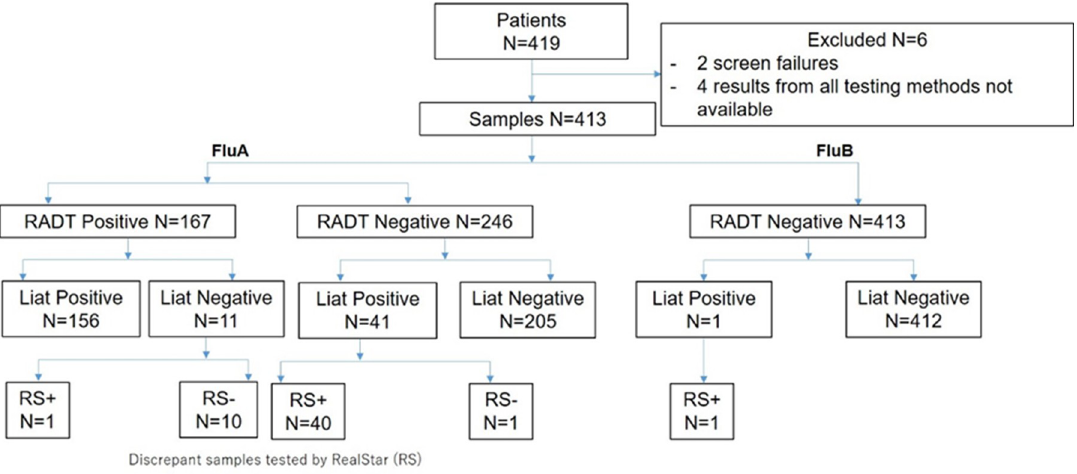
Fig 1. Patient flow. Discrepant samples were tested by RealStar; invalid RS samples (N = 4) were excluded from further analysis. RADT, rapid antigen diagnostic test; RS, RealStar.